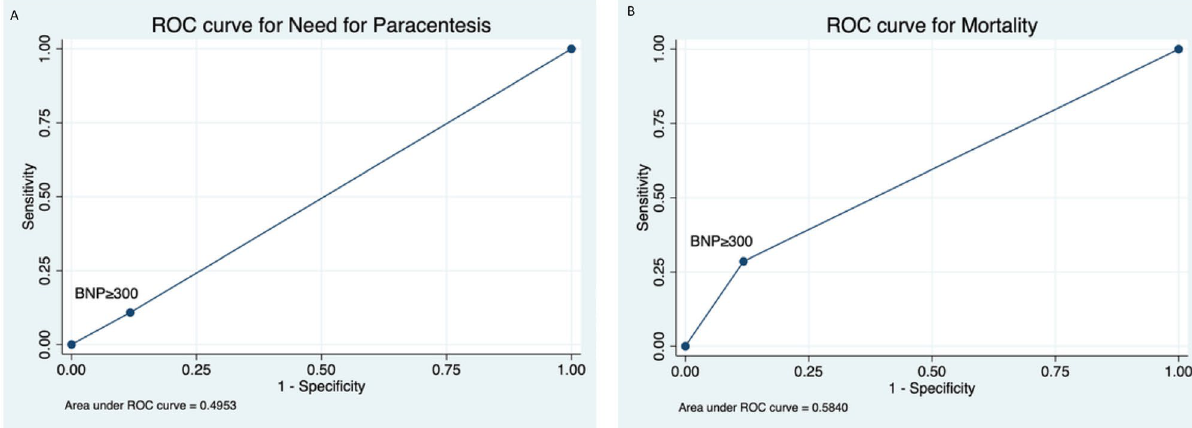
Figure 2. A ROC curve representing area under the curve, sensitivity and specificity for mortality based on BNP cut off = > 300. B ROC curve representing area under the curve, sensitivity and specificity for need of paracentesis based on BNP cut off = > 300.